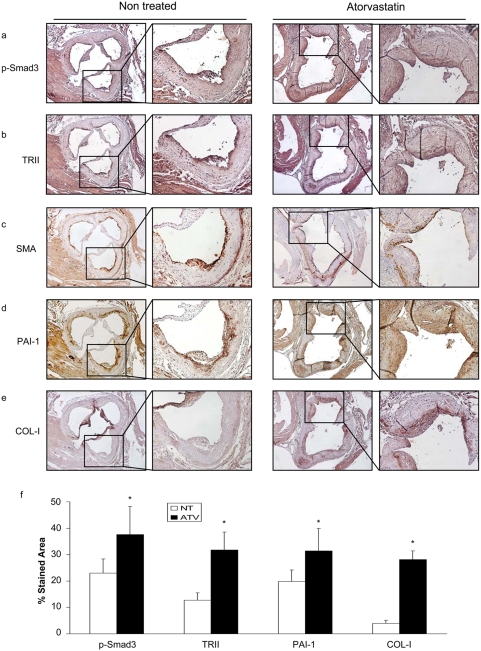
Atorvastatin increases the TGF-β/Smad signaling in vivo.ApoE-/- mice of 1 month age were feed with hyperlipidemic diet for 2 months and then randomized in two groups: non treated mice and treated with 5mg/kg/day of atorvastatin for 2 months. Animals were sacrificed and samples were embedded in paraffin. Aortic roots were stained by immunohistochemistry for p-Smad3 (a), TRII (b), Smooth Muscle Actin (SMA) (c), PAI-1 (d), and Type I Collagen (COL-1) (e). Figure shows a representative mouse of each group of 8. magnification 40× and 100×. Panel f shows the quantifications of the histological observations. This was performed by an independent observer, using Metamorph software, and following manufacturer's instructions.